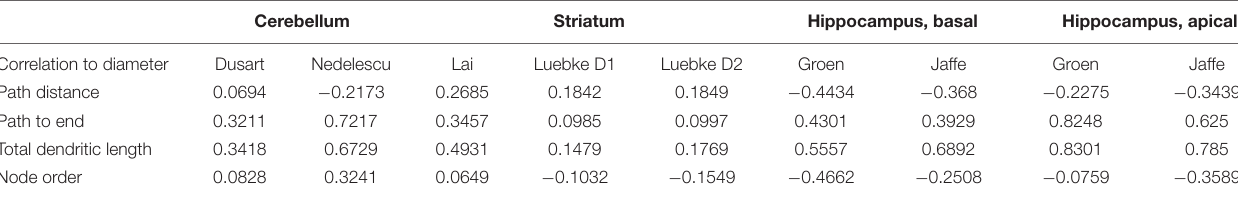
TABLE 3 | Correlation between morphological features and diameter by archive. Cerebellum Striatum Hippocampus, basal Hippocampus, apical